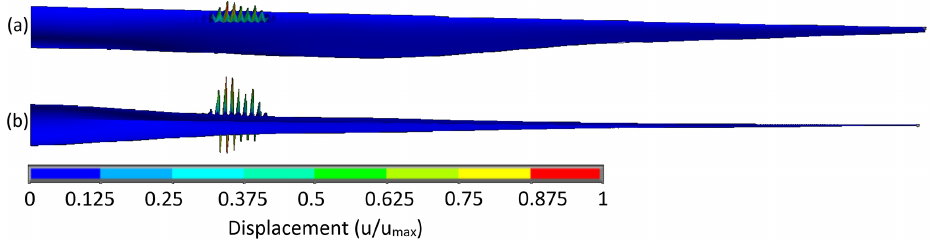
Figure 11. Displacement plot of the most critical buckling mode for the optimized BAR-DRG design viewed from the (a) suction side and (b) trailing edge.